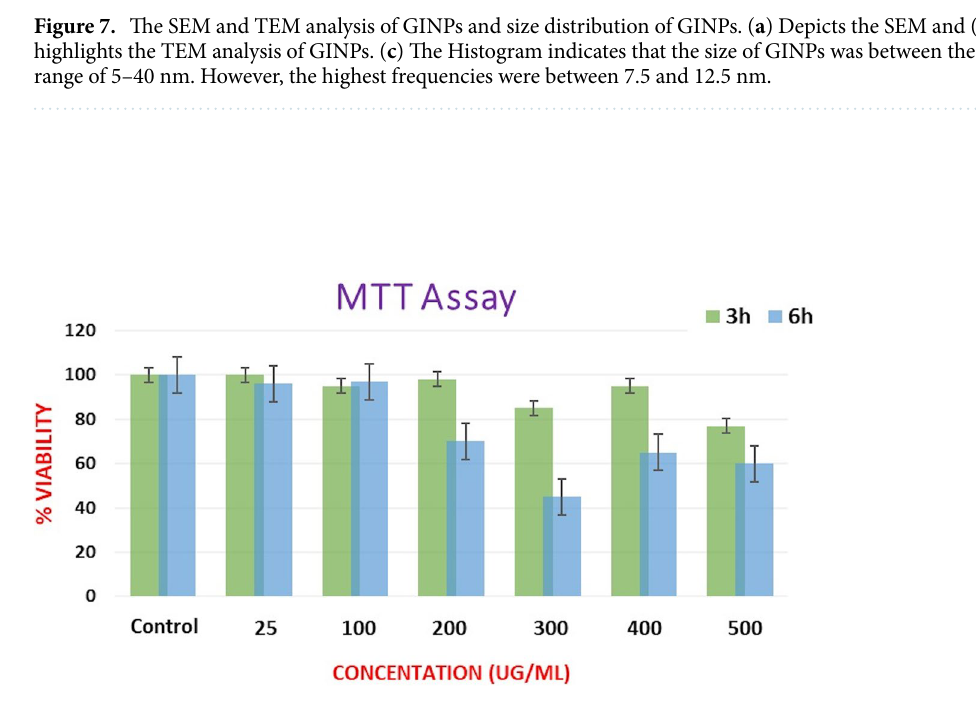
Figure 8. The cytotoxicity analysis of GINPs. The effects of superparamagnetic iron oxide nanoparticles on cell proliferation and viability of J774 cells as determined by MTT assay. Concentration-dependent cytotoxic effects of nanoparticles evaluated after three and six hours of incubation. Results are represented as means ± standard error of the mean. *Significant difference from control (P <